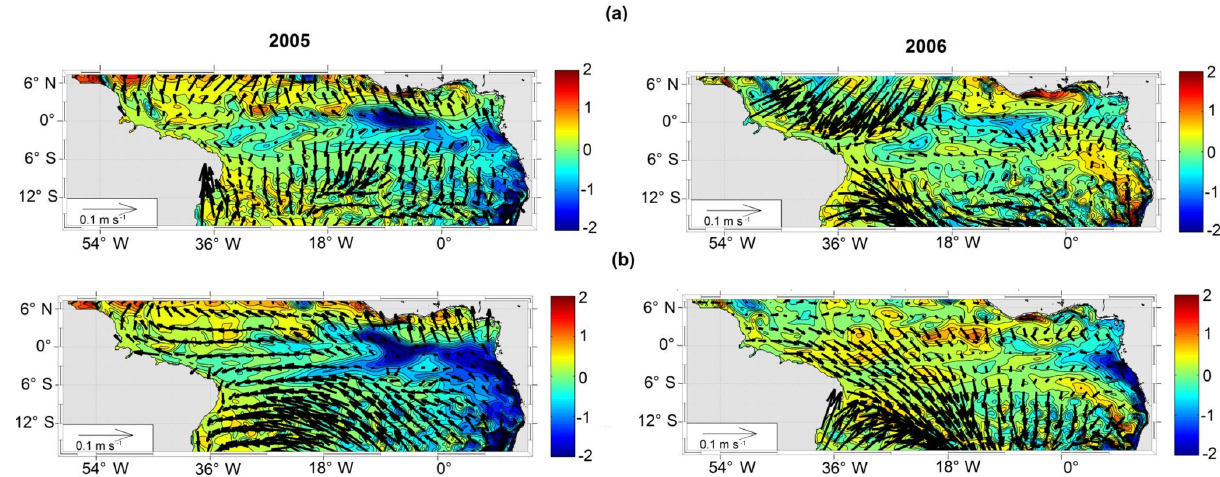
Figure 8. (a) Intraseasonal anomaly of sea surface temperature ( ◦ C; color) superimposed with intraseasonal anomaly of wind stress intensity (arrows) averaged over 1–12 May 2005 (a) and over 14–30 May (a) ; (b) same but for 2006. For details about the calculations of the anomalies, see Sect.